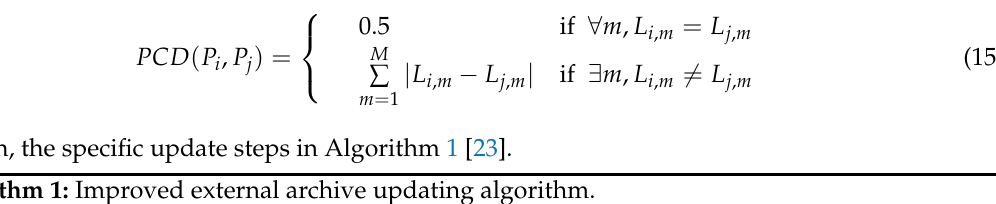
Algorithm 1: Improved external archive updating algorithm.